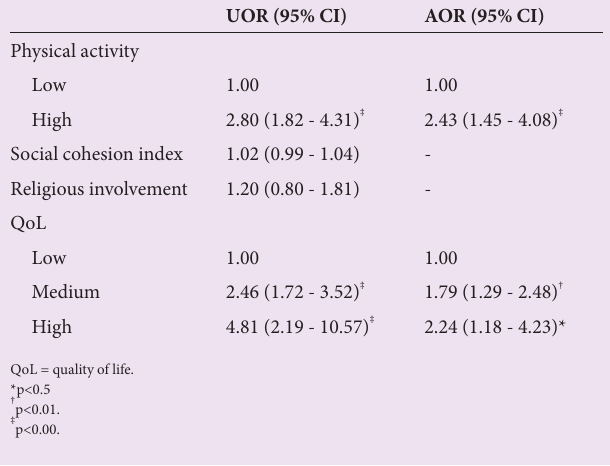
Table 2 (continued). Multivariate logistic regression with cognitive functioning in older South